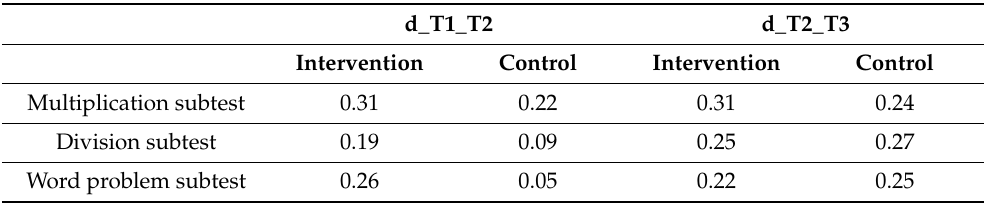
Table 5. Change in domain-related performances according to post and follow-up tests’ results (in terms of Cohen’s-d). d_T1_T2 d_T2_T3 Intervention Control Intervention Control Multiplication subtest 0.31 0.22 0.31 0.24 Division subtest 0.19 0.09 0.25 Word problem subtest 0.26